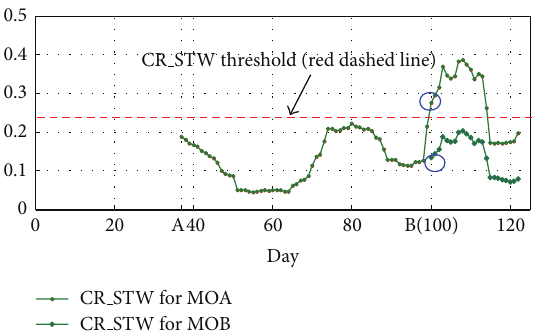
Figure 8: False positive rate and true positive rate of images with strong indications in a sliding window of 15 days before and after the update of the reference model image set.